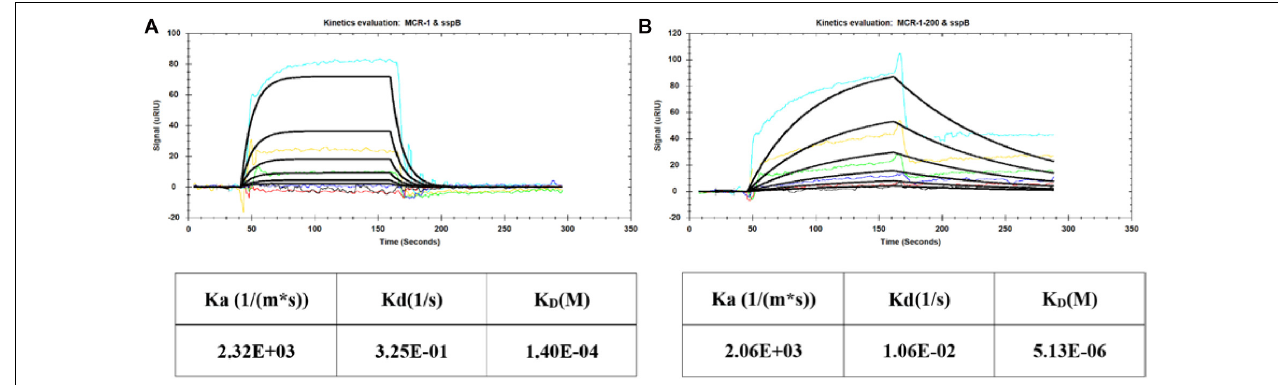
FIGURE 3 | SPR interaction analysis of MCR-1 and SspB protein. (A) Kinetic evaluation of MCR-1 full length protein and SspB; (B) Kinetic evaluation of MCR-1-200 catalytic domain protein and SspB. The SspB was diluted with PBST running buffer in the concentration range of 0.156–5 µ M with twofold dilution series.